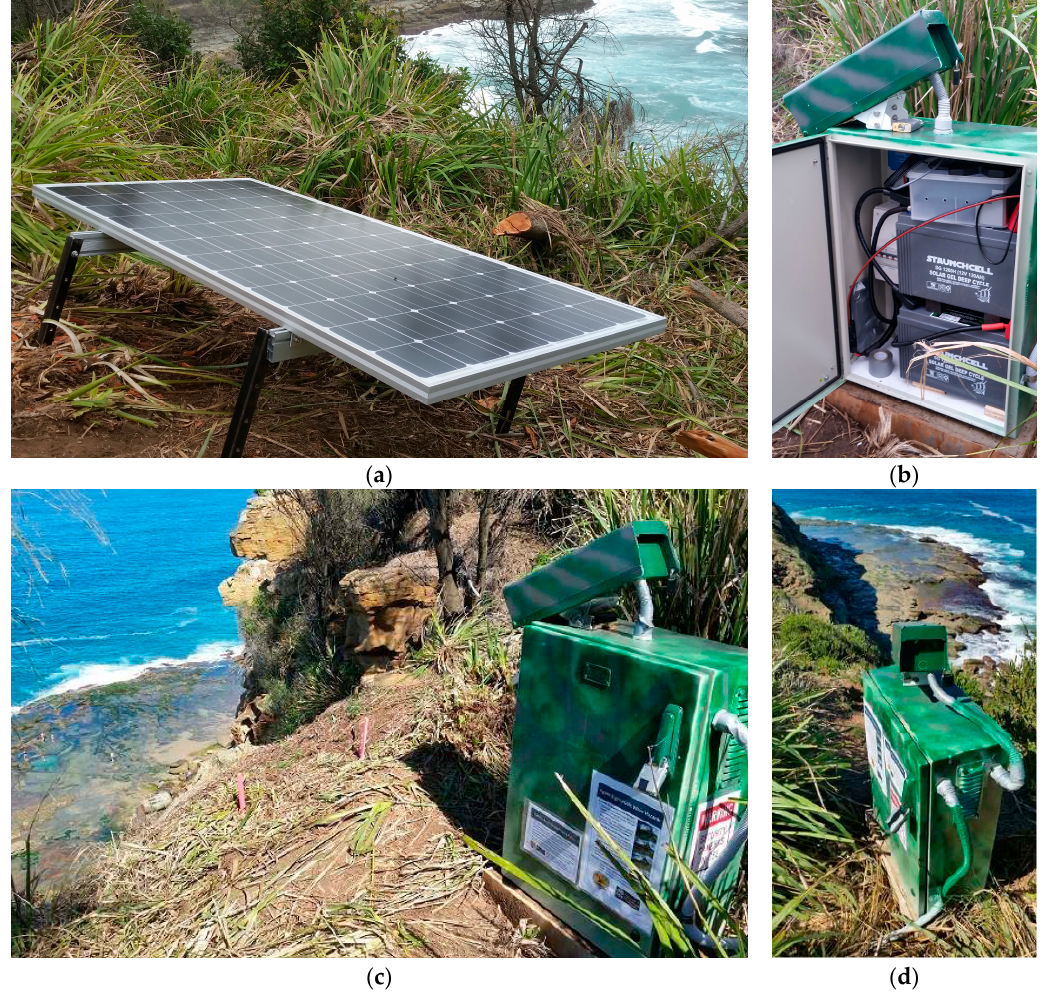
Figure 5. Camera setup on site showing ( a ) the solar panel; ( b ) the gel batteries, solar regulator, and power converters; and the cameras mounted in the security camera housings and the battery housing box for ( c ) the north camera and ( d ) the south camera.